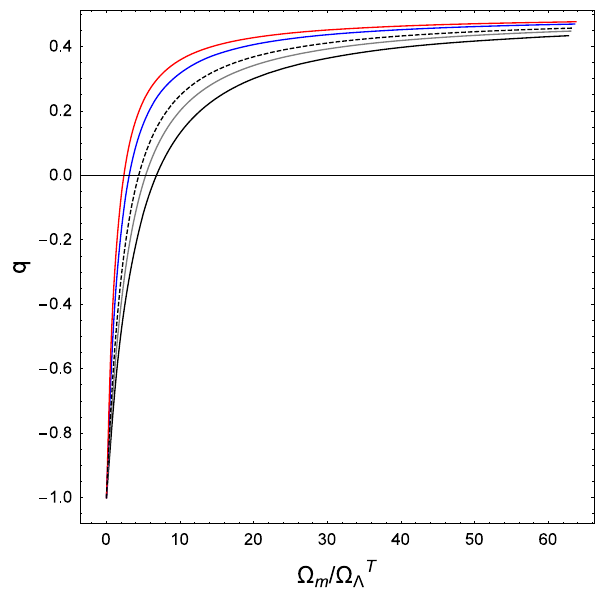
Fig. 5 The behavior of deceleration parameter against the ratio (cid:8) /(cid:8) T 2 = 0 . 3136, (cid:8) 0 m (cid:7) for D